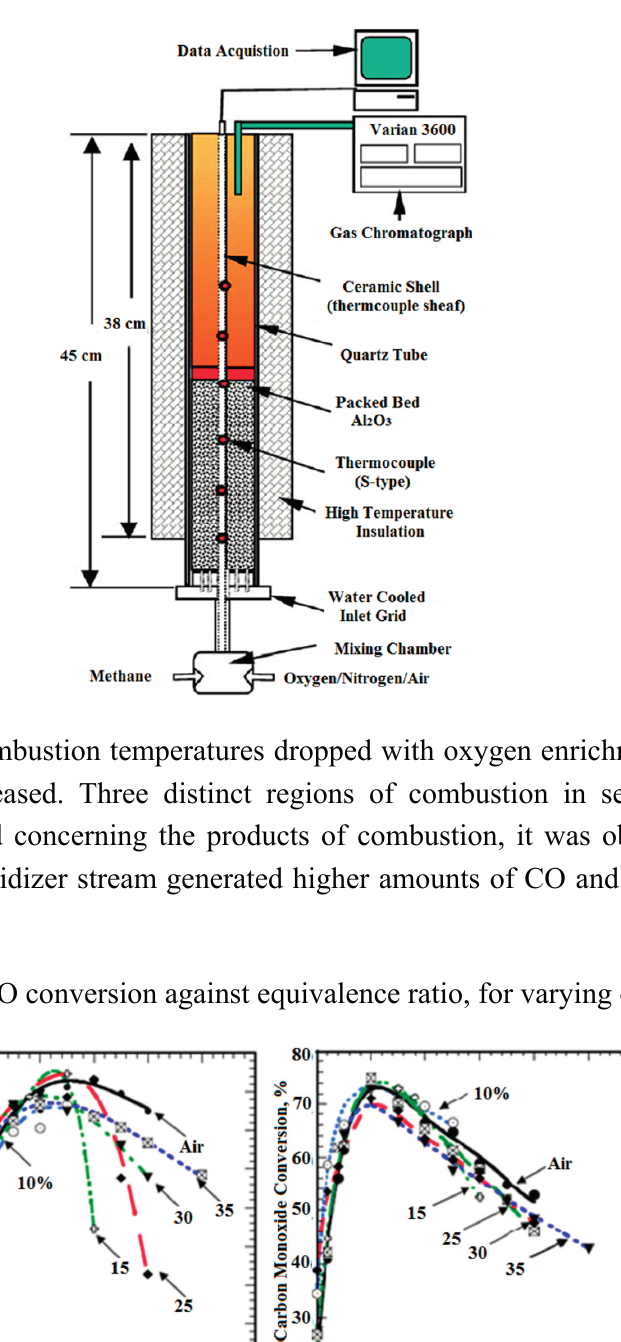
Figure 12. Experimental setup used in the second experiment by Bingue et al. [27].